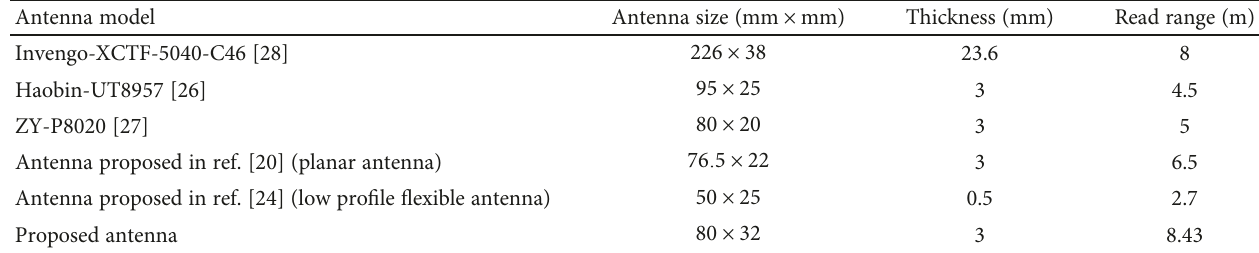
Table 2: Comparison between the proposed design and other